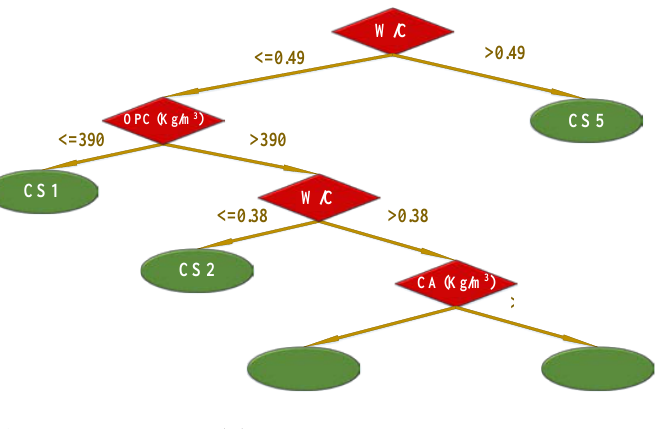
Figure 5. Architecture of ( a ) hybridized ANN with GA (ANNGA), ( b ) hybridized ANN with SSA (ANNSSA), and ( c ) hybridized ANN with GOA (ANNGOA).